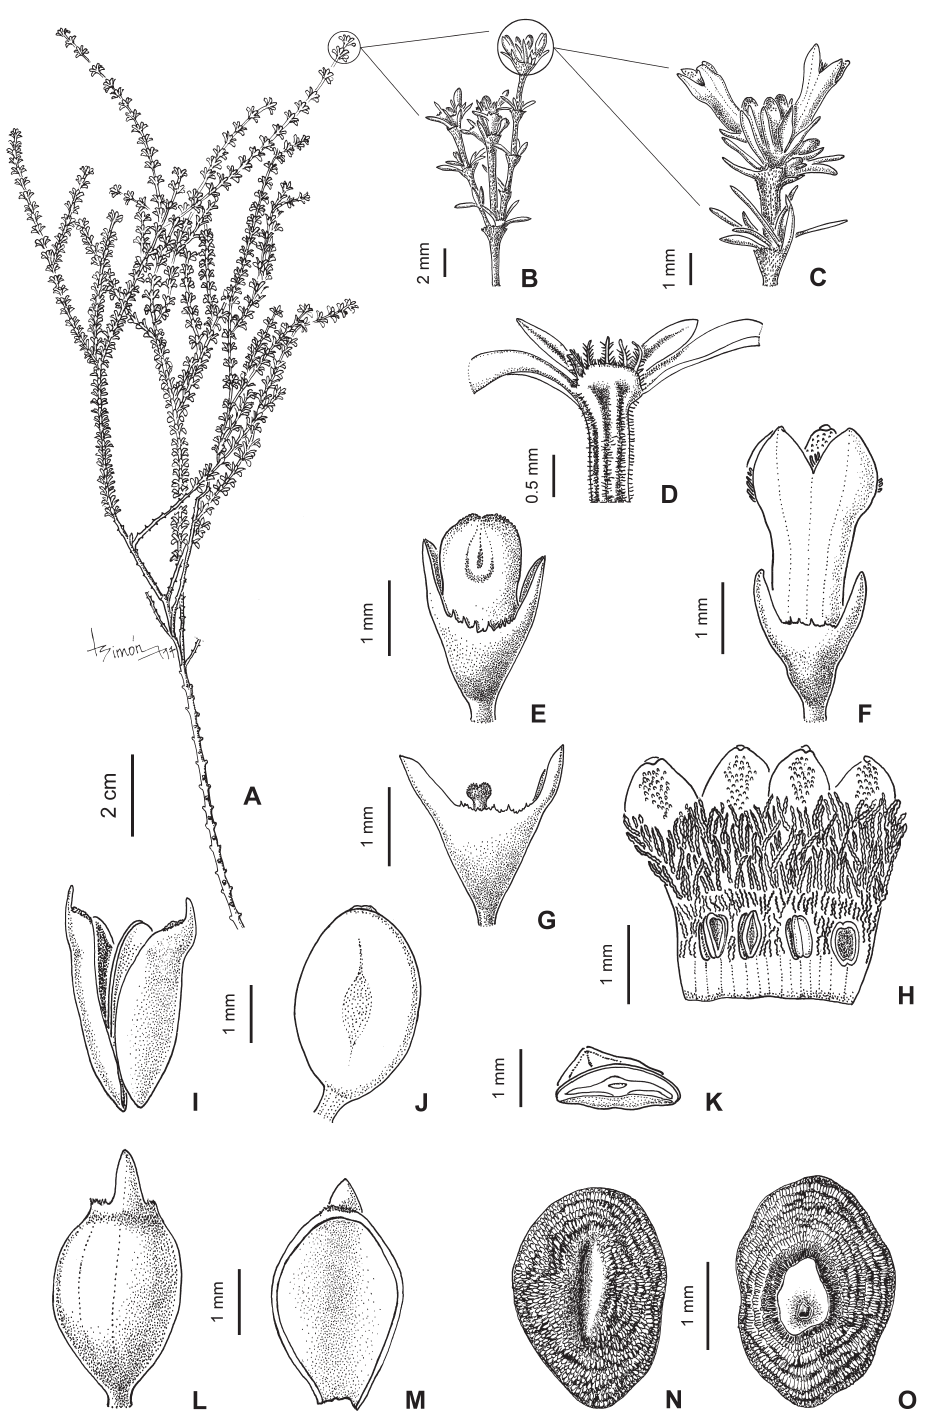
Fig. 1. Psyllocarpus itakangapyra Sobrado, J.A.M.Carmo & R.M.Salas sp. nov.; P.L. Viana et al. 4415 (CTES). A . Branch portion. B . Inflorescences at the apex of flowering branches. C . Detail of an inflorescence. D . Stipular sheath. E . Preanthetic flower bud. F . Flower. G . Hypanthium, calyx, style, and stigma. H . Opened corolla. I–M . Fruit. I . Dehiscent capsule, lateral view. J . Septum. K . Valve, seed, and septum, cross section. L . Valve, dorsal view. M . Valve, ventral view. N–O . Seed. N . Dorsal view. O . Ventral view. Illustration: L.